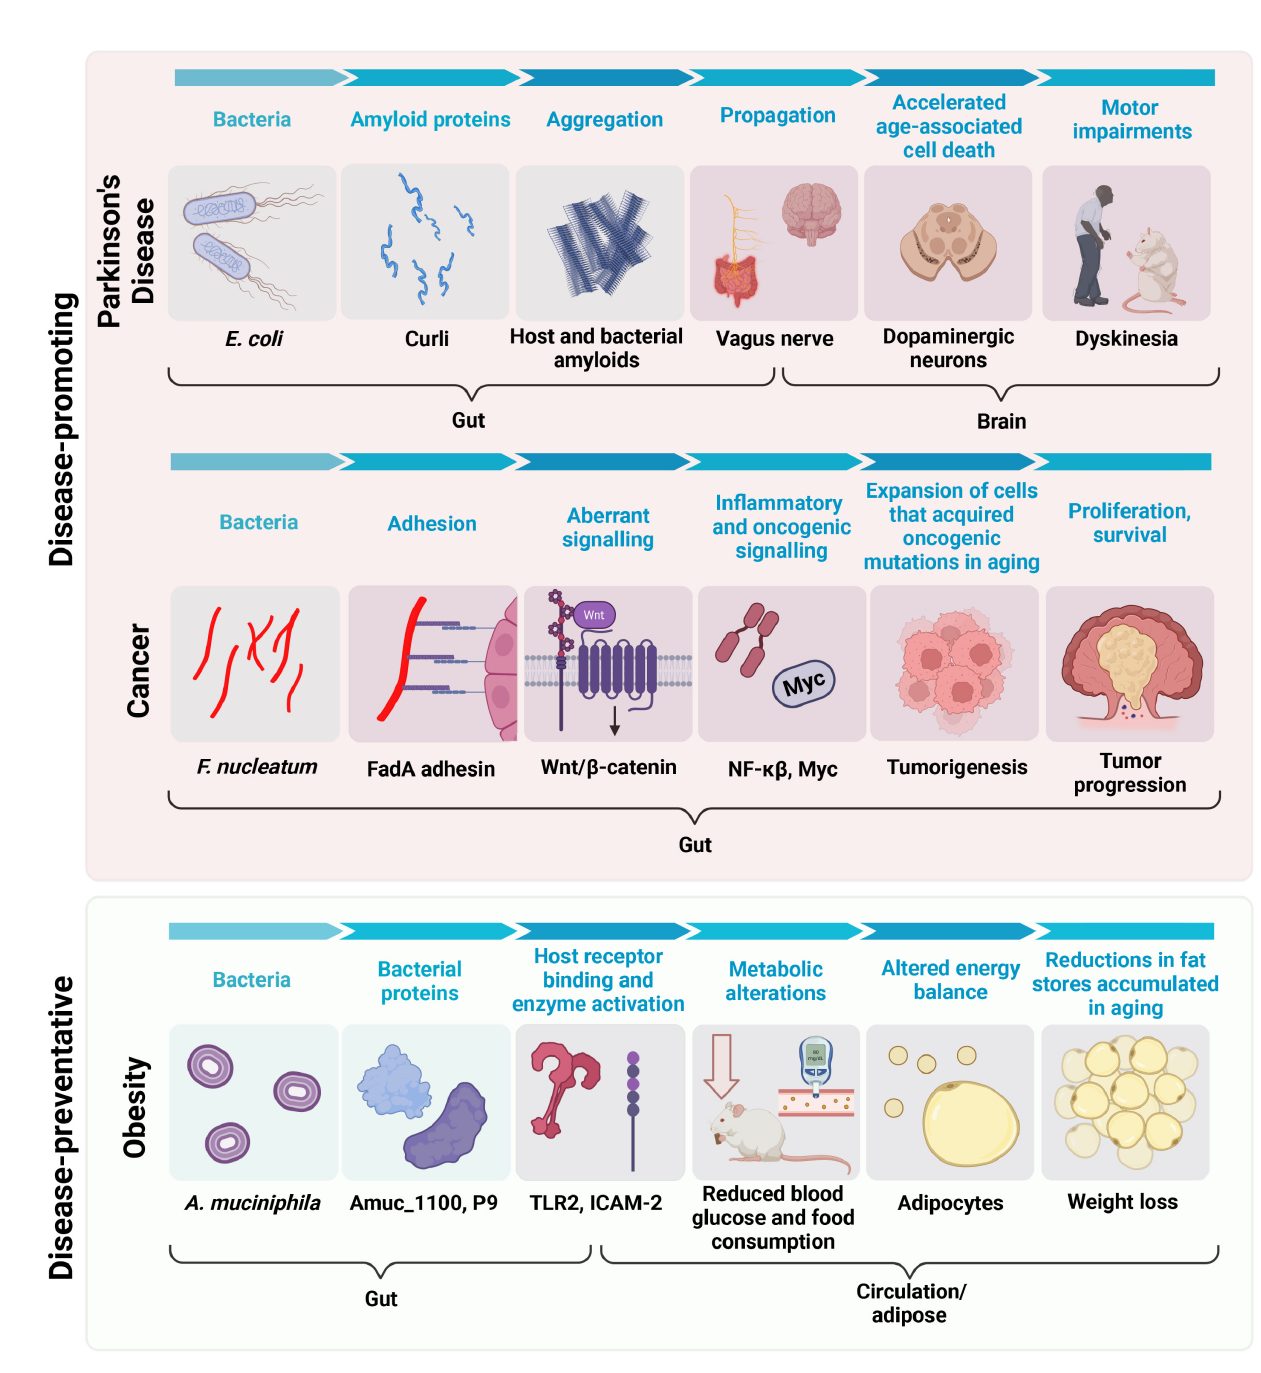
Fig 2. The microbiome influences age-associated disease. Diagram summarizing some of the mechanisms through which the microbiome has been implicated in 3 distinct age-associated diseases. We propose that the net effect of all these pathways shapes life span by dictating the risk and treatment of disease. Amuc_1100, A . muciniphilia protein 1100; FAD-A, Fusobacterium adhesin A; ICAM-2, intercellular adhesion molecule 2; NF- κ B, nuclear factor- κ B; P9, carboxyl-terminal protease; TLR2, Toll-like receptor 2. Created with BioRender.com.